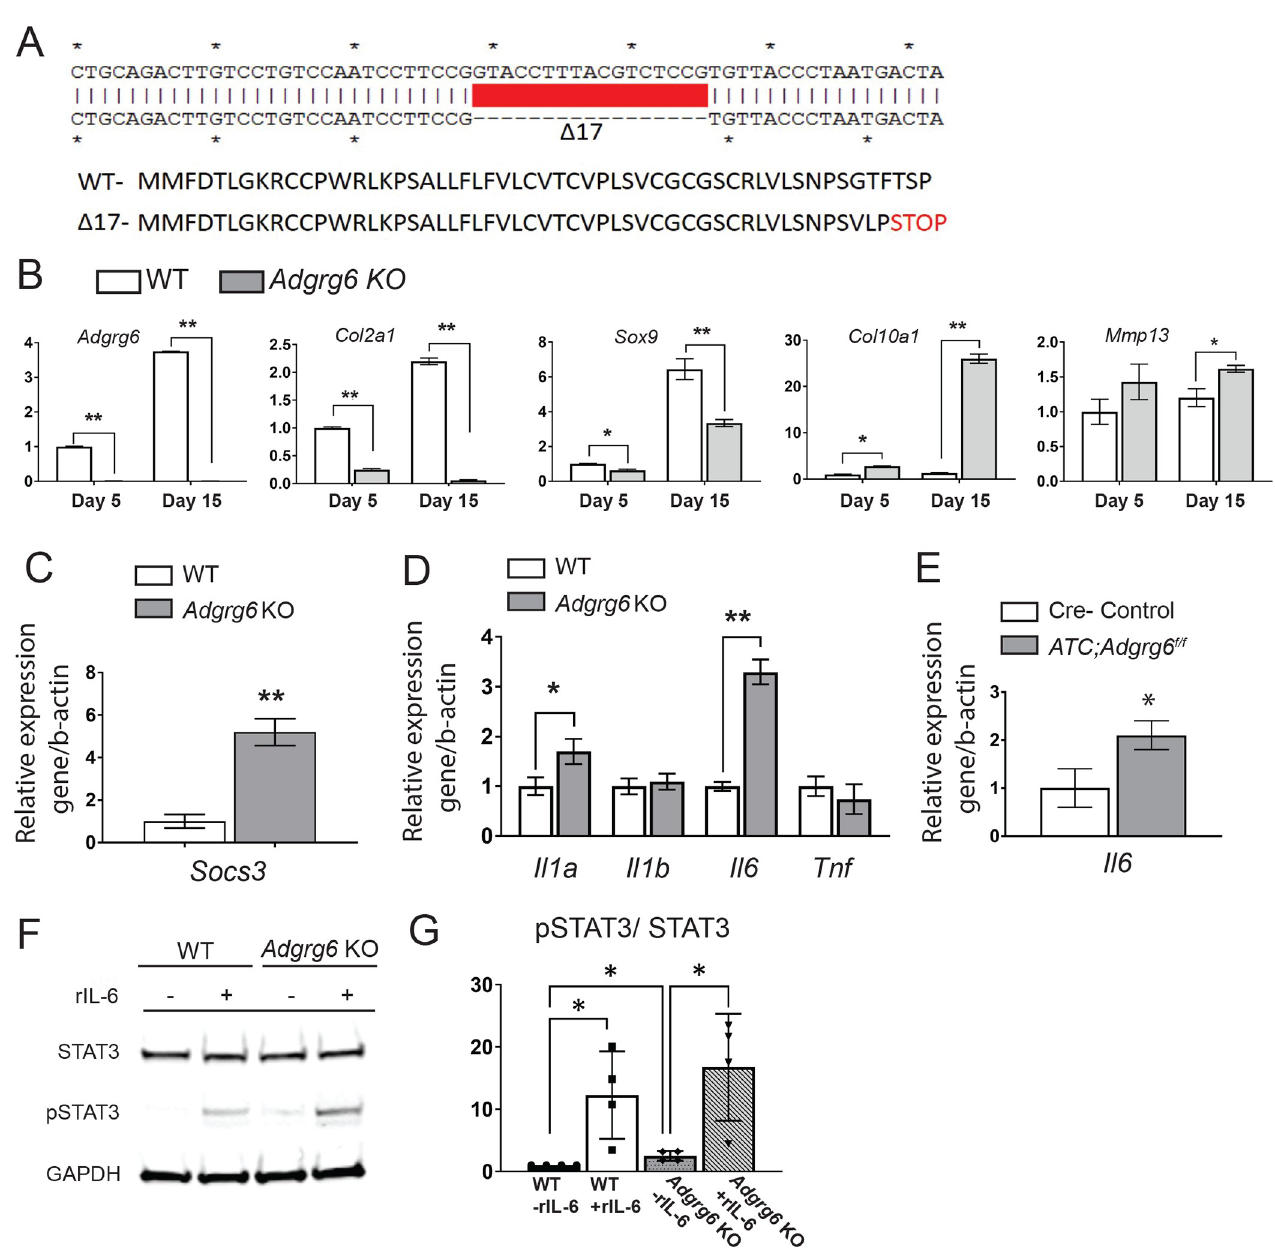
Fig 5. Adgrg6 regulates gene expression profiles and STAT3 signaling in ATDC5 cell culture. (A) Schematic of a 17-bp deletion of Adgrg6 from a stable single cell clone of ATDC5 cell line ( Adgrg6 KO). (B) qPCR analyses of gene expression in ATDC5 cells at 5 and 15 days of maturation demonstrates decreased expression of markers of healthy disc, Col2a1 and Sox9 , and increased expression of the hypertrophic marker, Col10a1 and the extracellular matrix modifying enzyme, Mmp13 in Adgrg6 KO cells. (C) qPCR analyses revealed increased expression of Socs3 in Adrgr6 KO cells after 15 days of maturation. (D) qPCR analysis of Il1a , Il1b , Il6 and Tnf in ATDC5 cells maturated for 15 days. (E) qPCR analysis of Il6 expression in 1.5-month-old primary mouse IVDs (induced from E0.5-P20). (B-E, n = 3 biological replicates and representative result is shown. Bars represent mean ± SD. � p � 0.05, �� p � 0.01, two-tailed Student’s t Test). (F) Representative Western blot of wild type and Adgrg6 KO ATDC5 cell lysates showing stimulation of pSTAT3 staining after treatment with recombinant IL- 6 (rIL-6) protein in both cell lines, while Adgrg6 KO cells show a mild constitutive stimulation of pSTAT3 without addition of rIL-6 ( n = 4 biological replicates and representative result is shown). (G) Densitometry of the Western blot of wild type and Adgrg6 KO ATDC5 cell with or without IL-6 (rIL-6) treatment. (Each dot represents one biological replicate. Bars plot with mean ± SD. � p � 0.05, two-tailed Student’s t Test.)